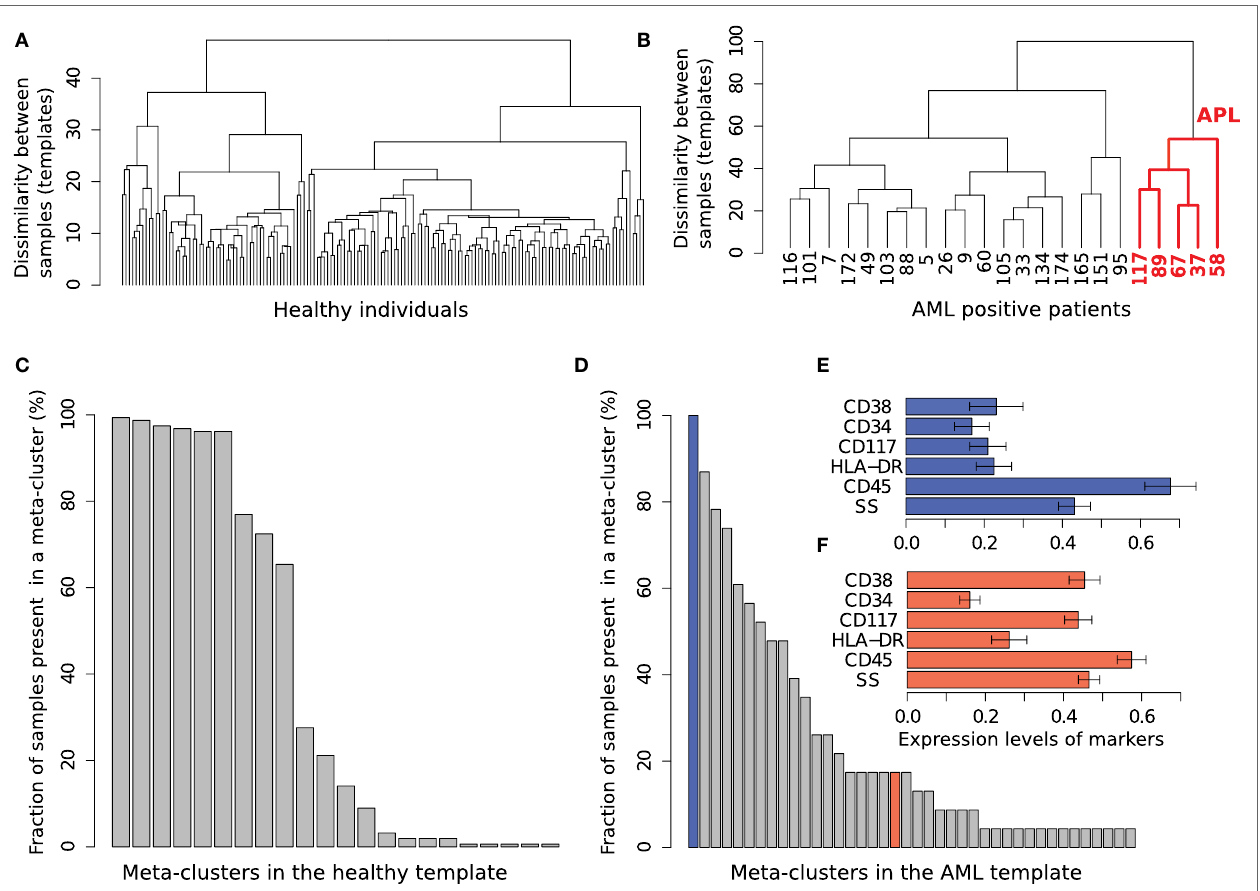
FigUre 12 | The healthy and aMl templates created from Tube 6 . (a) The template tree created from 156 healthy samples in the training set. (B) The template tree created from 23 AML samples in the training set. Samples in the red subtree exhibit the characteristics of acute promyelocytic leukemia (APL) as shown in (F) . (c) Fraction of 156 healthy samples present in each of the 22 meta-clusters in the healthy template. Nine meta-clusters, each of them shared by at least 60% of the healthy samples, form the core of the healthy template. (D) Fraction of 23 AML samples present in each of the 40 meta-clusters in the AML template. The AML samples, unlike the healthy ones, are heterogeneously distributed over the meta-clusters. (e) The expression levels of markers in the meta-cluster shown with blue bar in (D) . [Each horizontal bar in (e,F) represents the average expression of a marker and the error bar shows its SD]. This meta-cluster represents lymphocytes denoted by medium SS and high CD45 expression and therefore does not express the AML-related markers measured in Tube 6. (F) Expression of markers in a meta-cluster shown with red bar in (D) . This meta-cluster denotes myeloblast cells as defined by the SS and CD45 levels. This meta-cluster expresses HLA-DR − CD117 + CD34 − CD38 + , a characteristic immunophenotype of APL. Five AML samples sharing this meta-cluster are similar to each other as shown in the red subtree in (B)